Question: What form of chart is displayed?
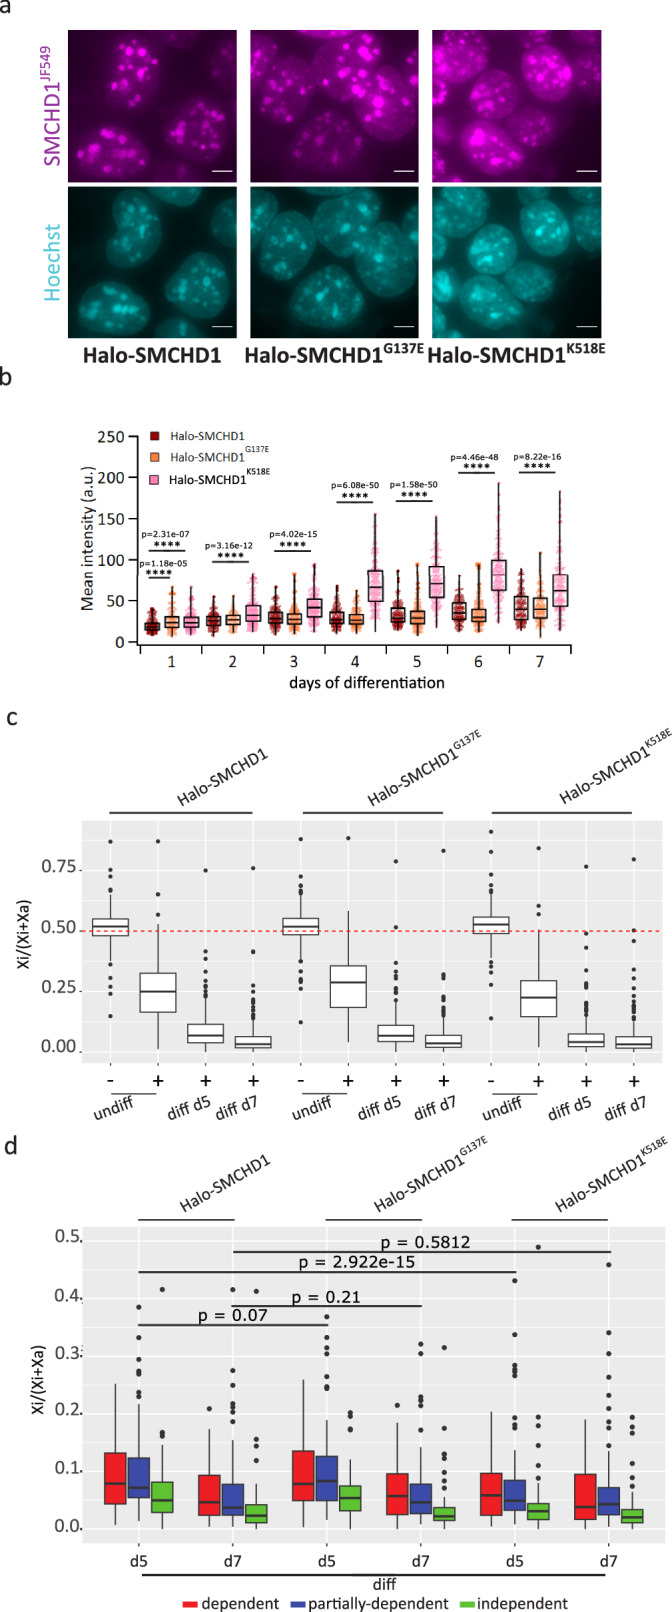
Answer: box